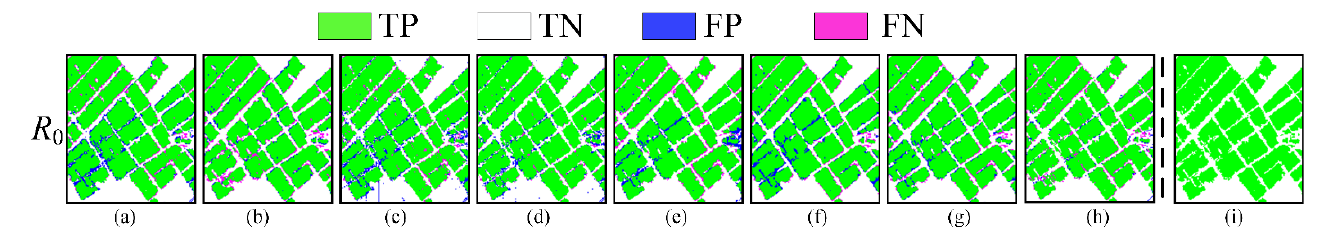
Figure 10. Detection details of the selected region R 0 on the China dataset using different methods: ( a ) CVA, ( b ) SSIM, ( c ) ISFA, ( d ) IRMAD, ( e ) MaxtreeCD, ( f ) Unet, ( g ) SGCL, ( h ) SSCF, ( i ) Ground-truth.